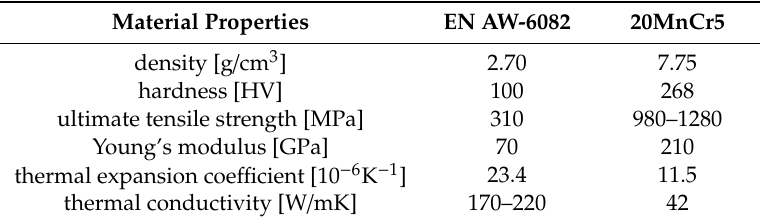
Table 1. Material properties.